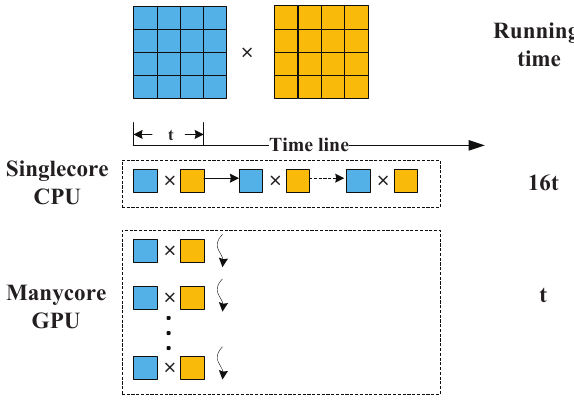
Figure 2. The comparison of phase multiplication between CPU and